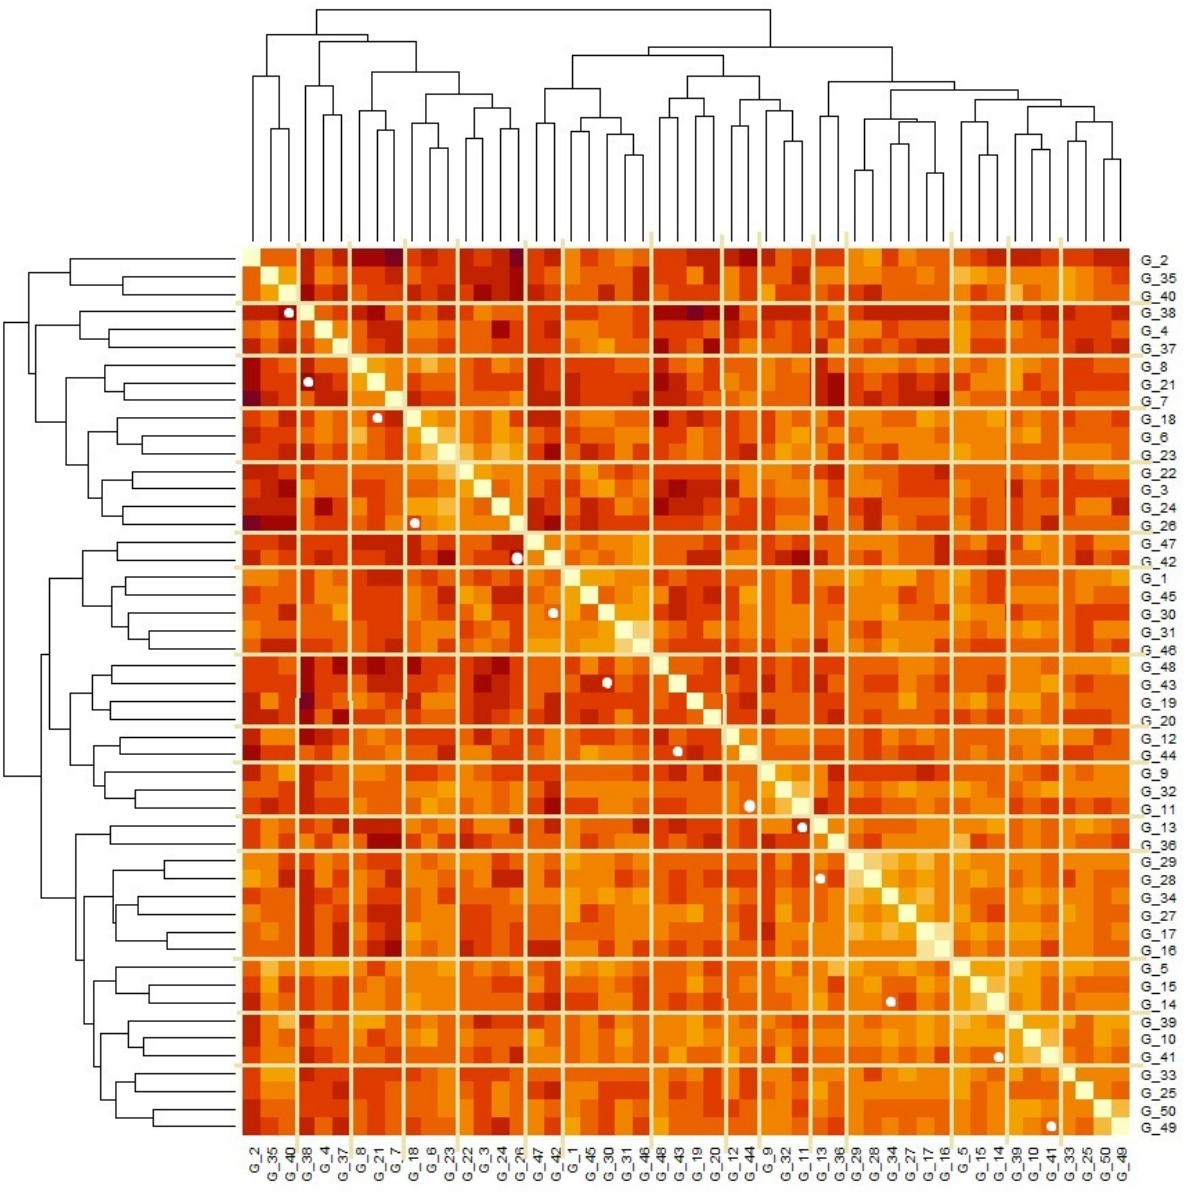
Figure 2. Heatmap of 50 accessions; 15 individuals are selected for the core collection (white dots). Shades of orange color indicated the level of genetic similarity among individuals, determined from identity (light beige) to the lowest similarity (dark orange).